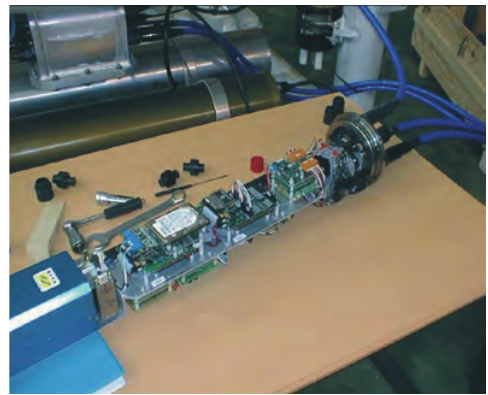
Fig. 2. DACS equipped with central Bottom Sta- tion high-precision clock (left-bottom) provided by SERCEL (former ORCA Instrumentation).